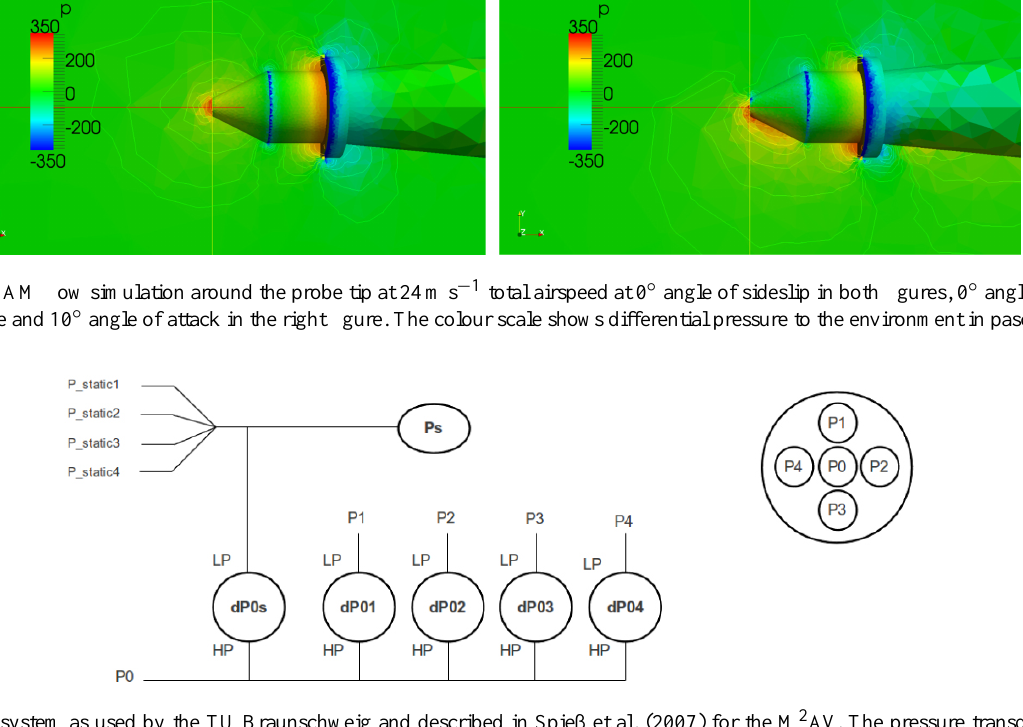
Fig. 4. Tubing system as used by the TU Braunschweig and described in Spieß et al. (2007) for the M 2 AV. The pressure transducer mea- surements d P 0 i are differential pressure readings of the low pressure port (LP) connected to the holes P 1– P 4 and the ring portholes P static compared to the high pressure port (HP), which in this case is the common port P 0. Ps represents a barometric pressure